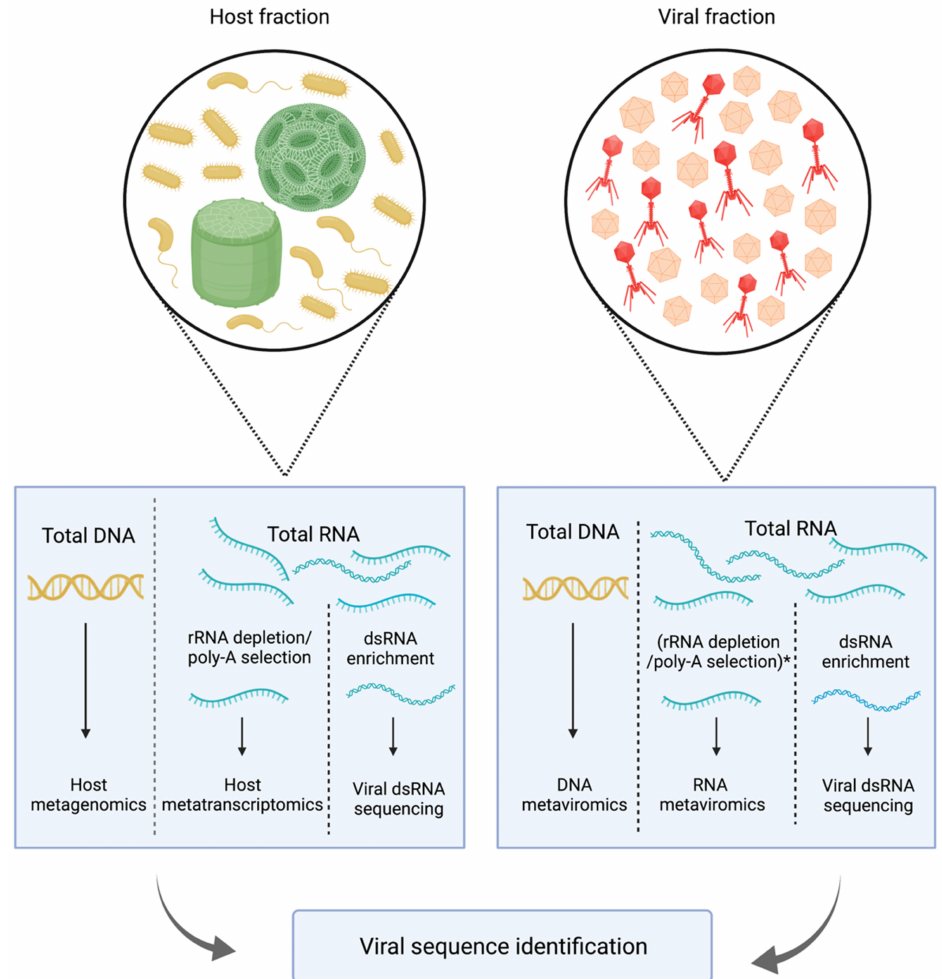
Figure 3. Most commonly used meta-omic sequencing approaches in marine virology. Host fraction (>0.22 µ m) metagenomes and metatranscriptomes are mined for viruses, or DNA or RNA is extracted from the enriched viral fraction (<0.22 µ m). * rRNA depletion or poly-A selection for RNA in the viral fraction is typically not performed due to low yields. An alternative approach that can enrich for replicative forms of RNA viruses inside the cells or for extracellular dsRNA viruses is dsRNA sequencing. Adapted from [30]. Created with